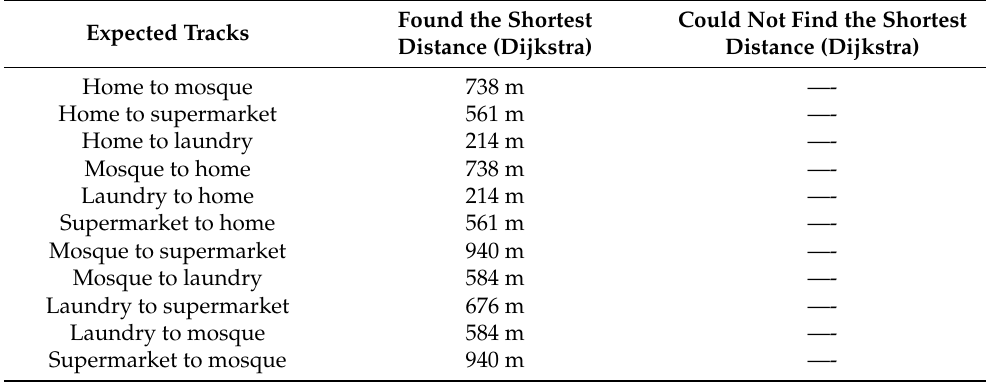
Figure 8. The shortest path first (SPF) algorithm used to determine the shortest path between points. Table 6. Dijkstra shortest path first (SPF) algorithm.